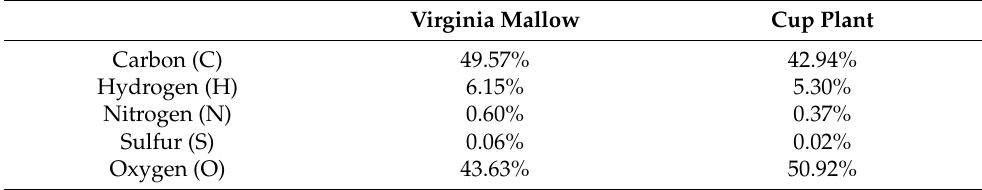
Table 2. Elemental analysis of Virginia mallow and cup plant